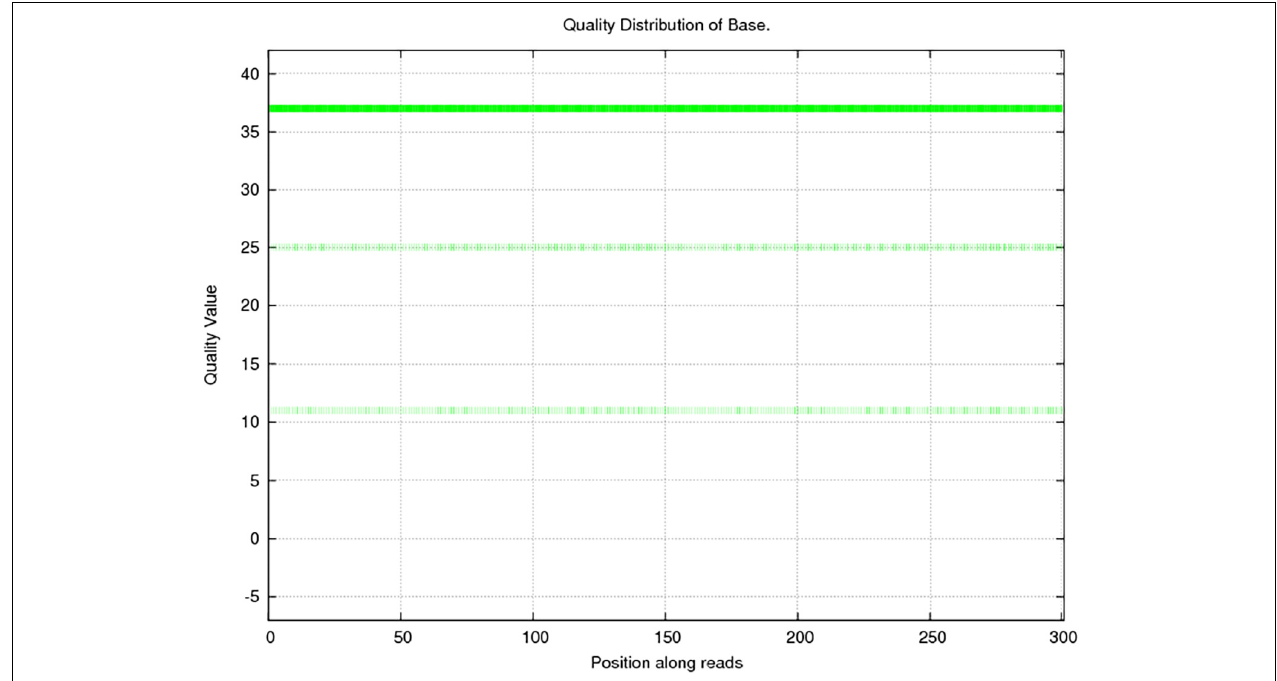
FIGURE 1 | Sequencing quality distribution of bases. The quality of the sequencing data was mainly distributed above Q20, which guarantees the normal conduct of subsequent high-level analyses. The abscissa presents the position on the reads, and the ordinate presents the base mass distribution over the position on the